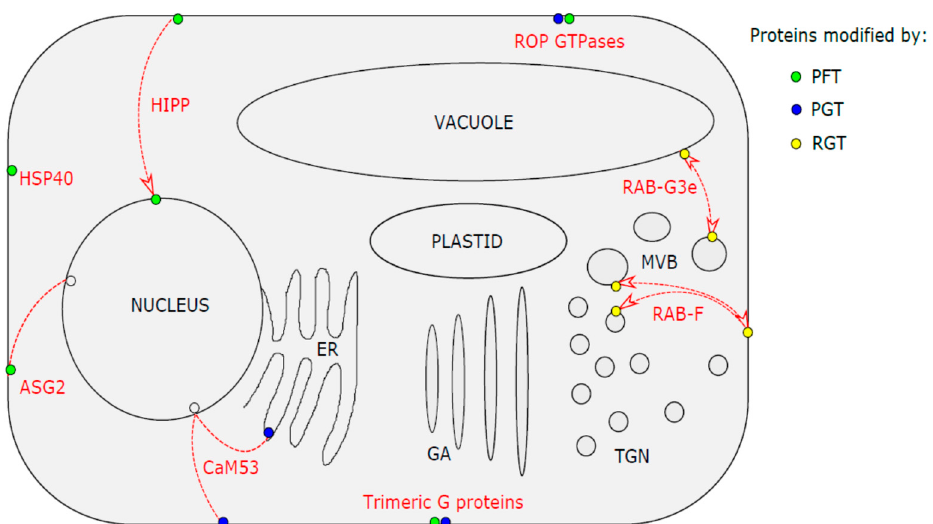
Figure 2. Graphical overview of sites of action relevant to protein groups involved in plant stress responses. Red lines connect localizations of different forms of proteins (also in red) as described in the text. When the direction of re-localization is applicable, it is marked by arrowheads. The colour of the circles corresponds to the modification reported (green – farnesylation by PFT, blue – geranylgeranylation by PGT, yellow – double geranylgeranylation by RGT, empty – non-prenylated). When two circles are present, both modifications were reported. ER- Endoplasmic reticulum, GA- Golgi apparatus, TGN- Trans-Golgi network, MVB- Multivesicular body.